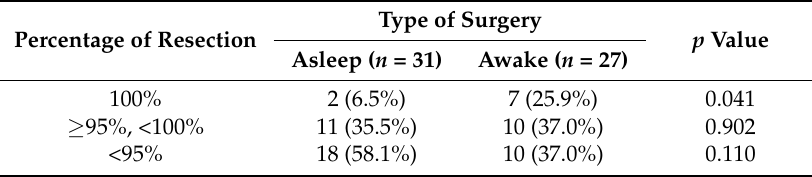
Table 1. Achieved resection of patients undergoing awake craniotomy (AC) for resection gliomas located in eloquent regions.